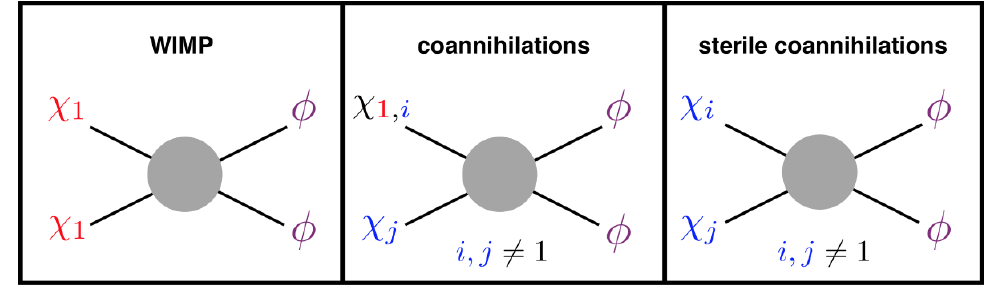
Figure 2 . Schematic representation of three phases of coannihilation for a set of DM particles, (cid:31) i , sharing a conserved quantum number. At late times, the heavier states decay to the lightest one, (cid:31) 1 , which comprises the DM today. In the WIMP phase, (cid:31) 1 (cid:31) 1 annihilations dominate. In the coannihilation phase, other annihilations dominate. In the sterile coannihilation phase, (cid:31) 1 does not participate in the dominant annihilations, and therefore the relic abundance of DM is independent of its